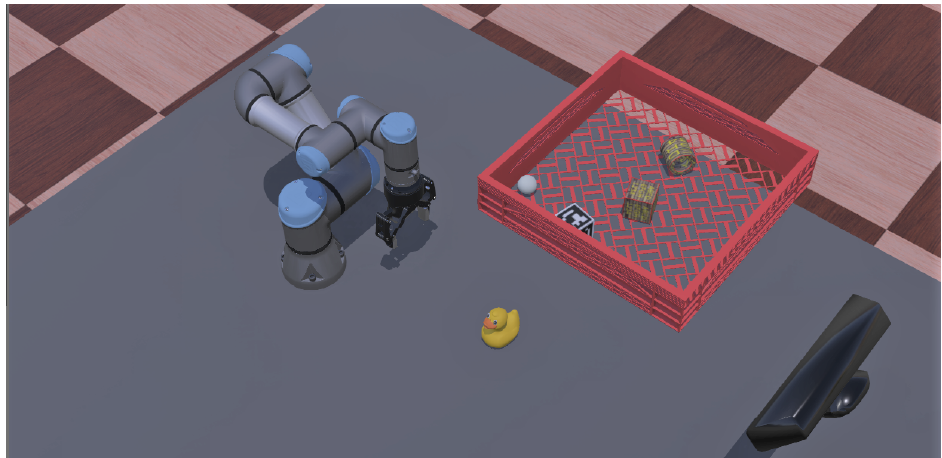
Figure 6. The virtual environment built on Webots: it consists of a table, a UR3e cobot ( left ) with a two-finger gripper, an RGBD camera ( right ) and the objects to be manipulated by the